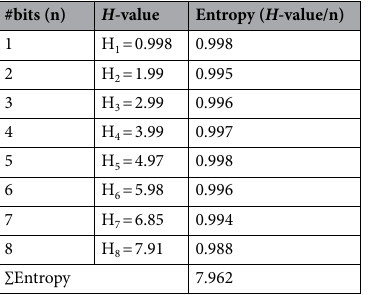
Table 5. Sample fitness score calculation. The entropy of each H value is